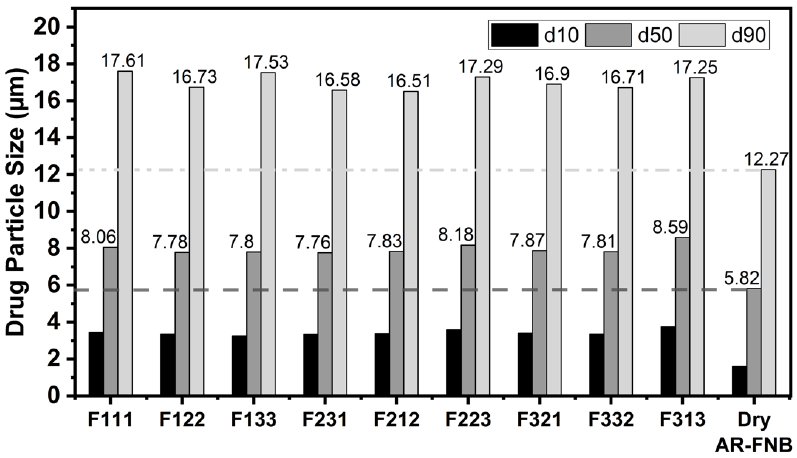
Figure 4. Particle size distribution of AR-FNB after re-dispersion from dried-films containing ~23 wt% drug concentration along with the particle size of dry AR-FNB.